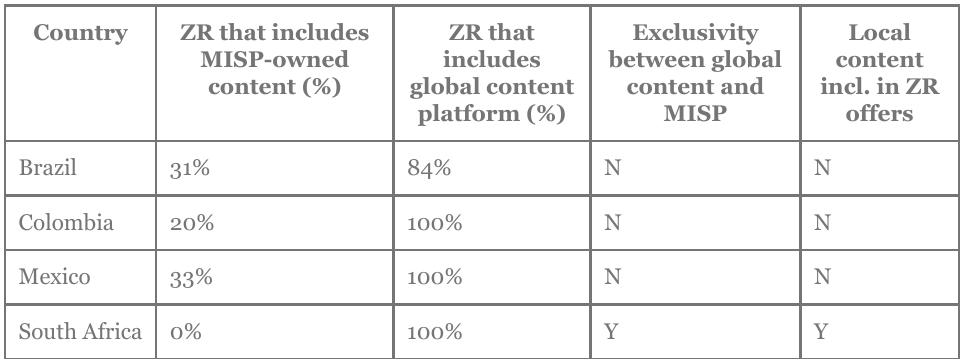
Table 4: Zero rated content